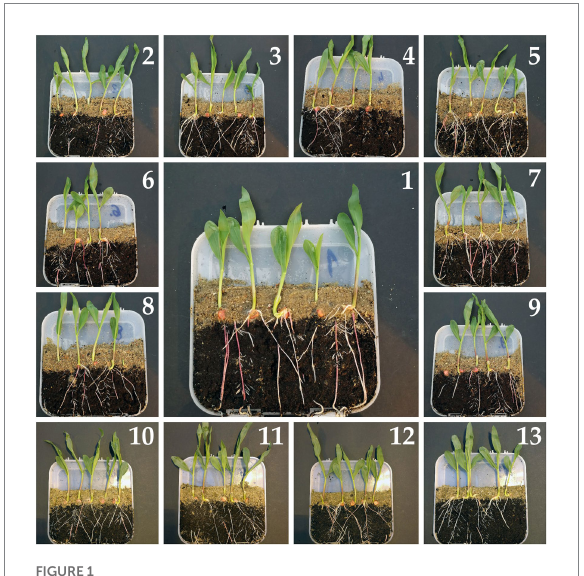
FIGURE 1 Rhizobox test allows to track root and seedling development as affected by various seed treatments. 1–13: Composition of seed treatments as shown in Table 1. Pictures show maize seedlings grown for 21 days.